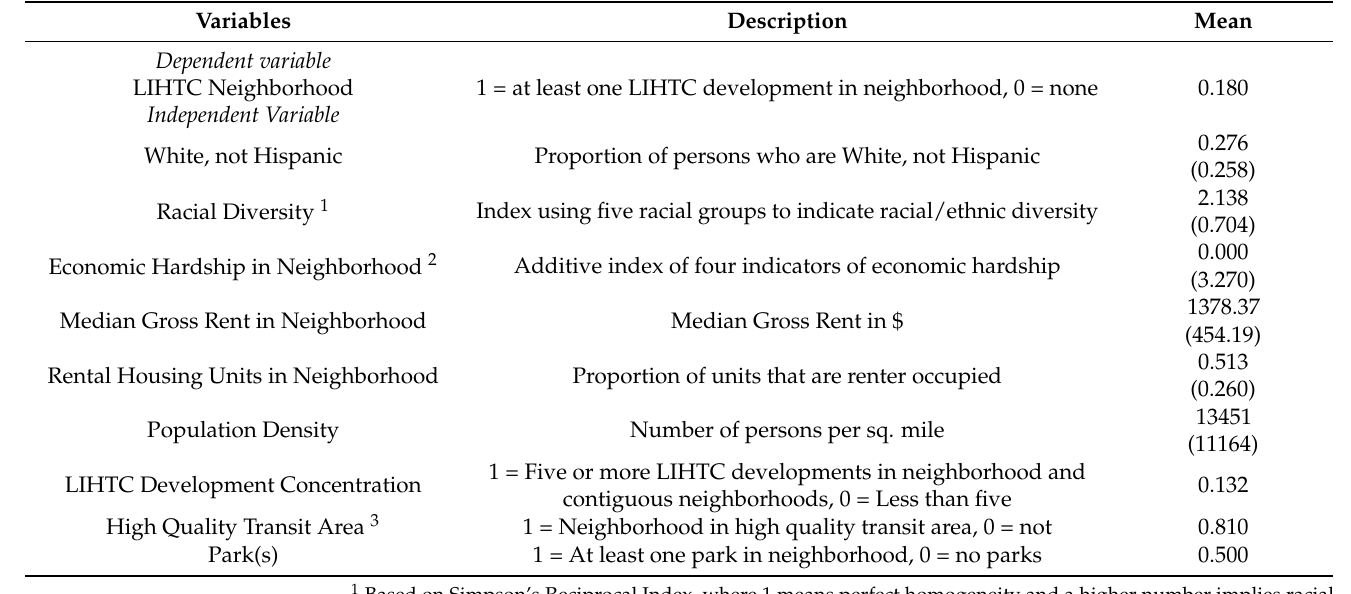
Table 6. Descriptive Statistics for Variables in the Model, Los Angeles